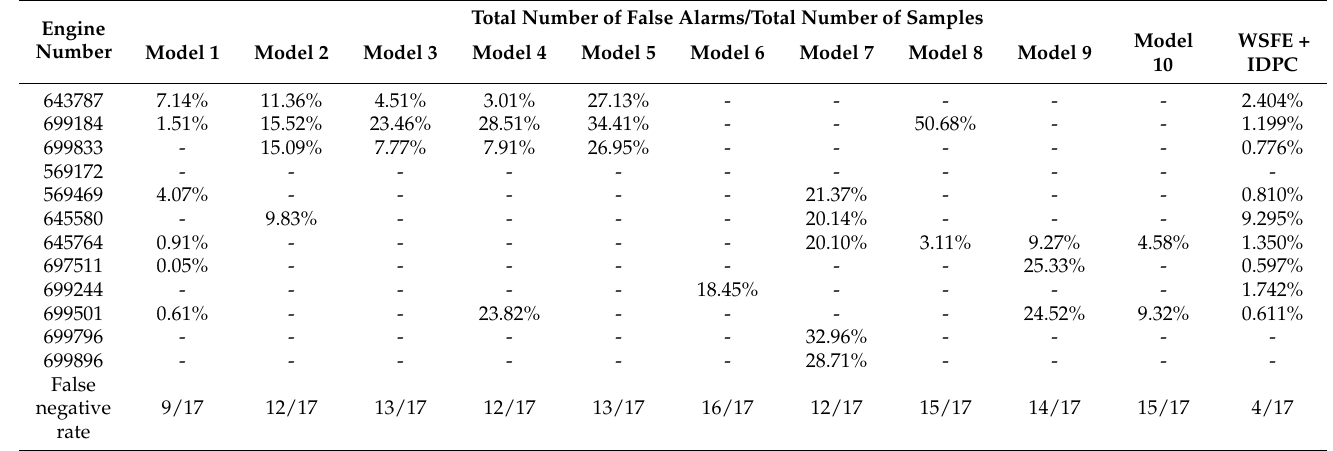
Table 8. Anomaly detection results of different models.